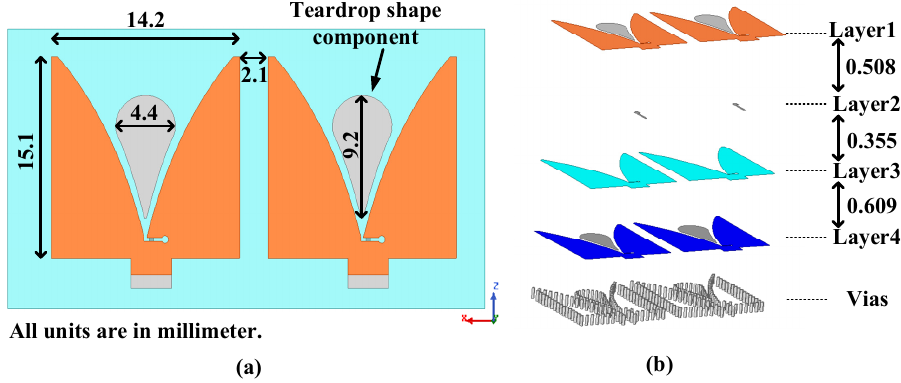
Figure 8. The configuration of the proposed antenna of ( a ) the front view and ( b ) the exploded view.